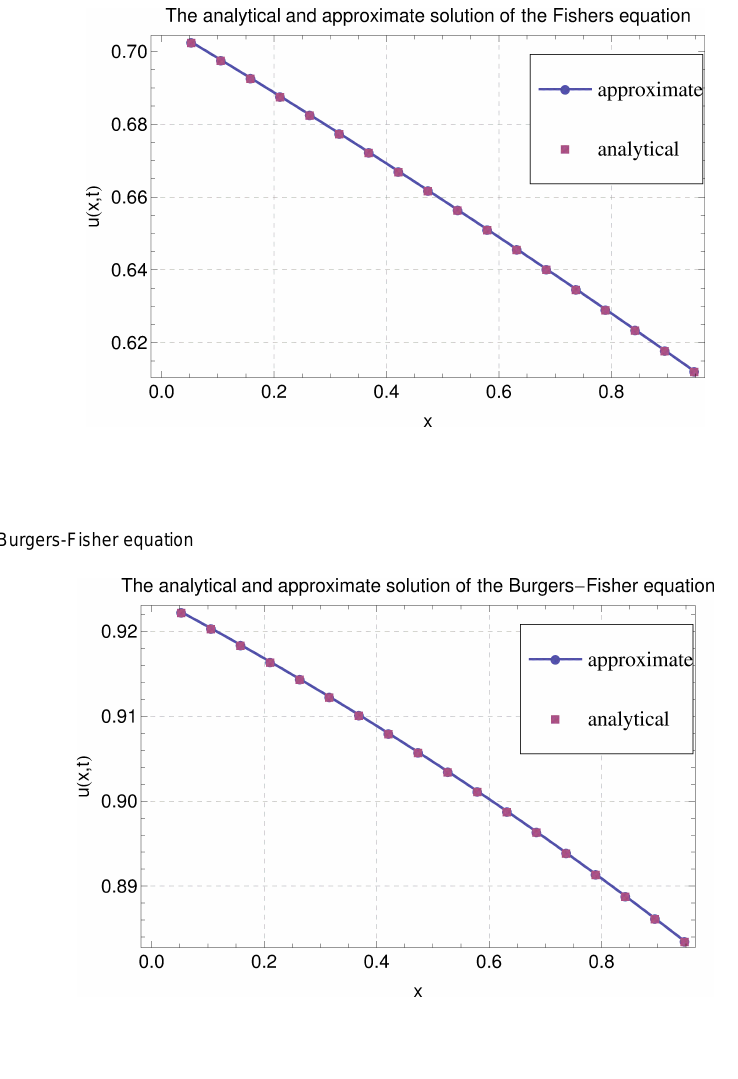
Fig. 3. Solution of the Burgers-Huxley